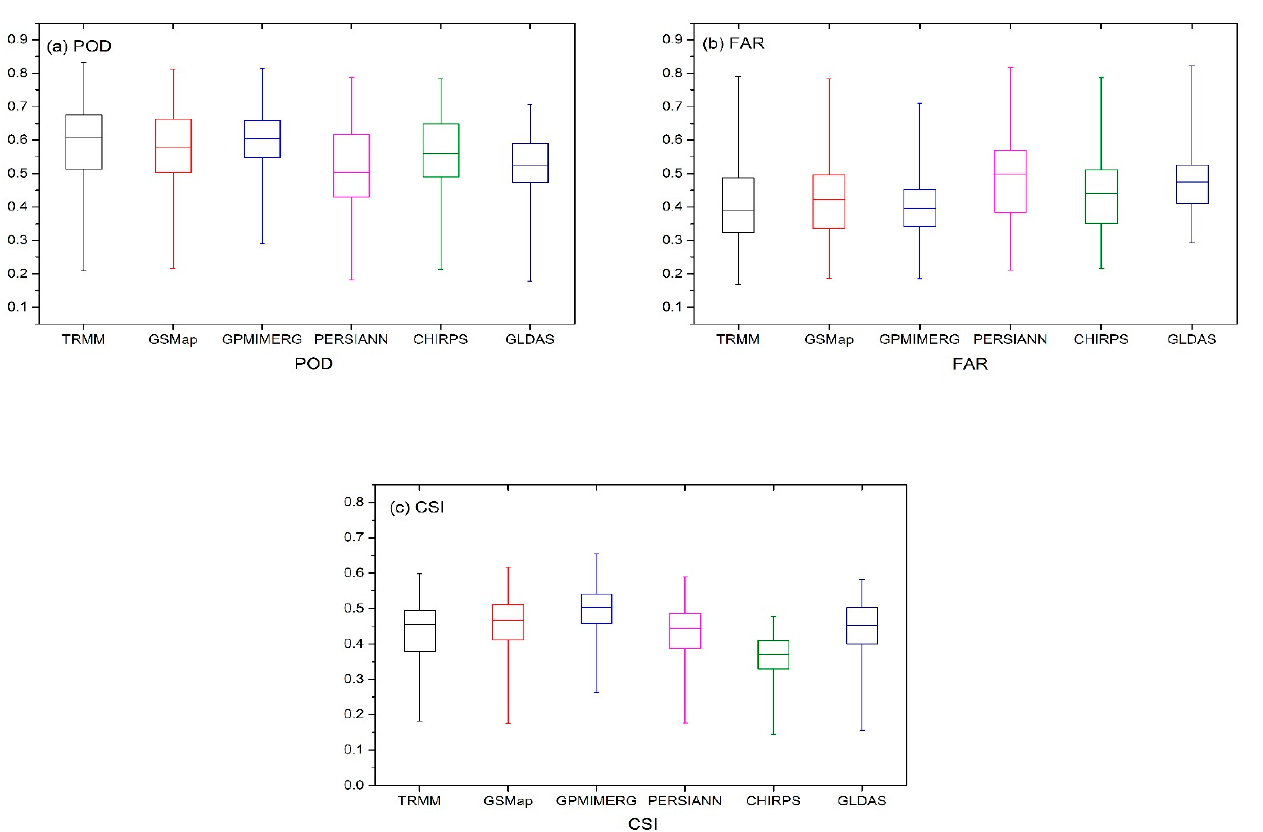
Figure 12. Classification index evaluation of six precipitation products. ( a ) represents the performance of POD of the six products, ( b ) represents the performance of FAR of the six products, (c) represents the performance of CSI of the six products. The line in the middle of the box represents the median value, each box ranges from the lower quartile (25th) to the upper quartile (75th), and the top and bottom lines represent the maximum and minimum values of each indicator, re- spectively.